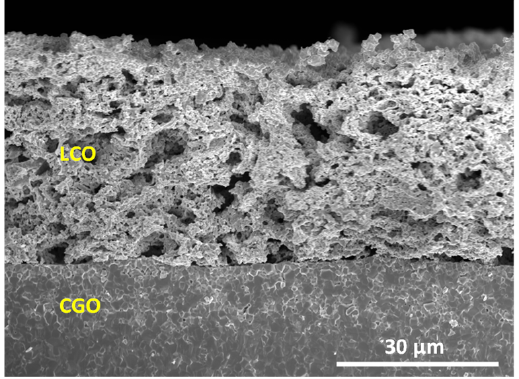
Figure 7. Cross-sectional SEM image of the LCO-CGO symmetrical cells sintered at 800 °C for 1 h.